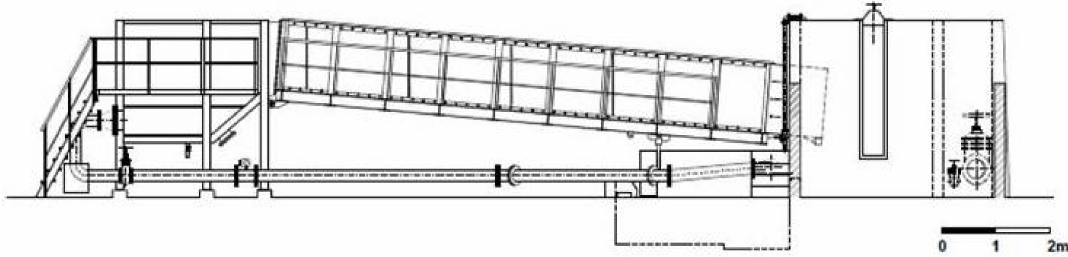
Figure 1. Vertical slot fishway (VSF) experimental flume, set on a slope of 8.5%. Flow runs from left to right.